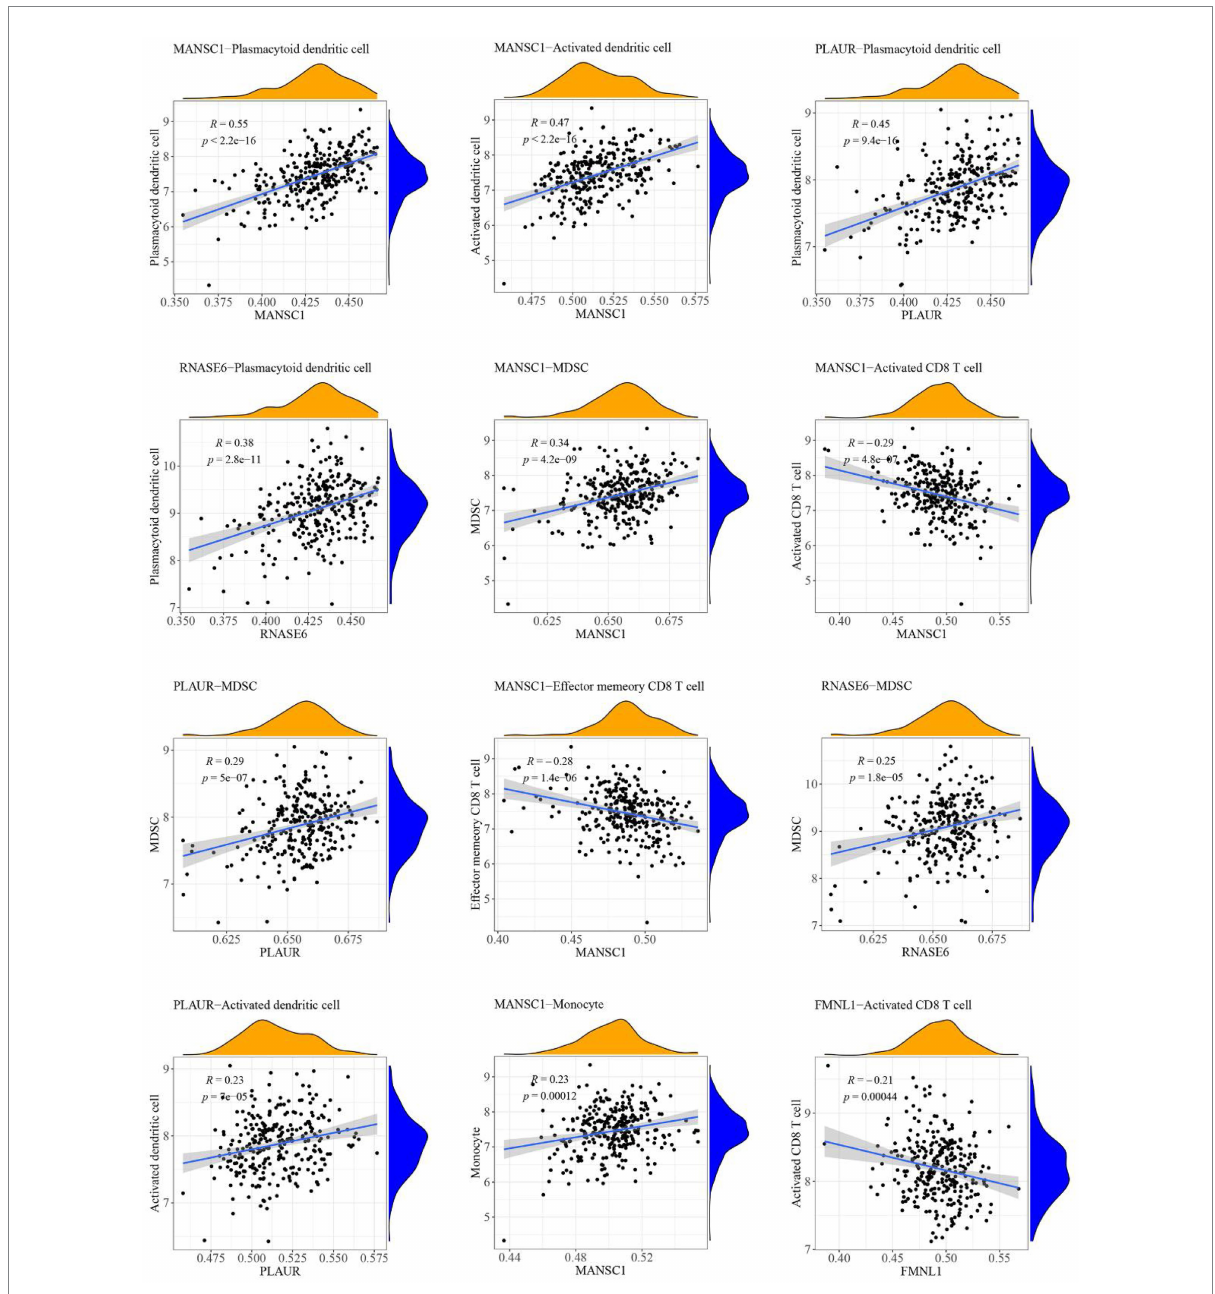
FIGURE 13 Relationship between high-abundance immune cells and hub cross-talk gene in Parkinson’s